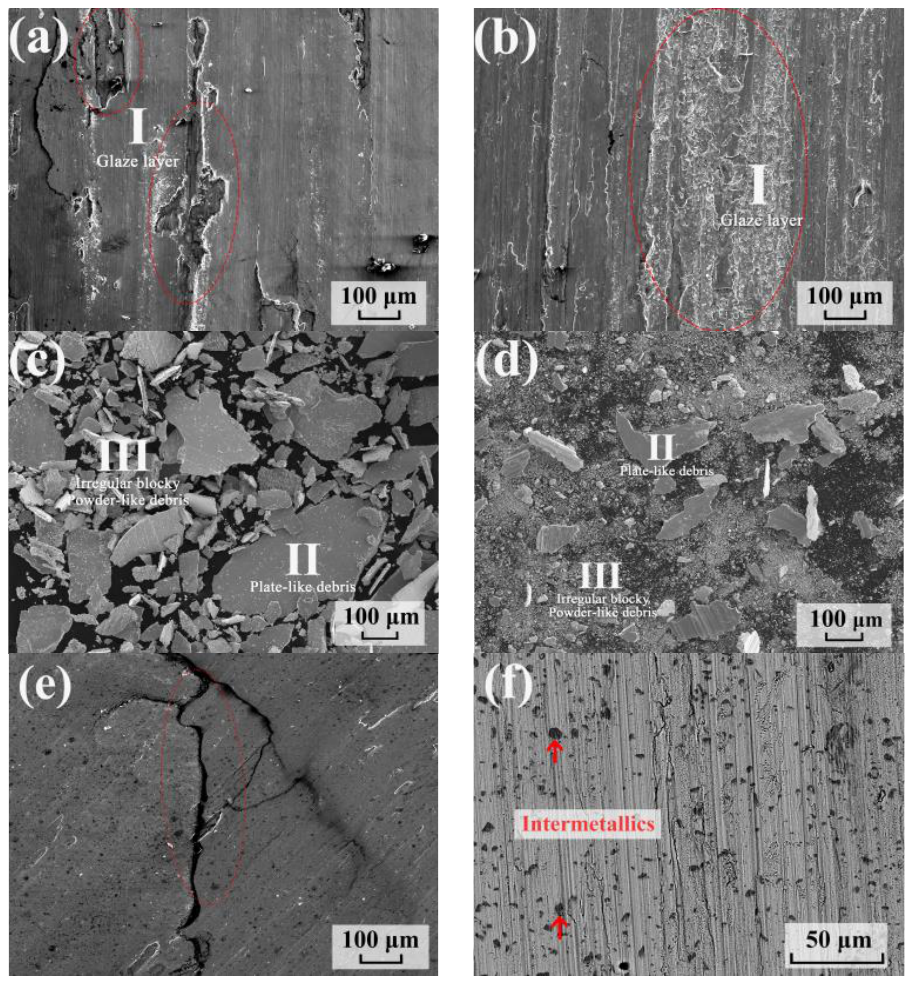
Figure 5. Wear surface and debris of ( a , c ) C17200 alloy and ( b , d ) the Cu 86.5 alloy after pin-on-disc test, ( e ) crack on C17200 surface, and ( f ) intermetallic compound left on the surface. Table 2. Composition of wear surface and debris of C17200 and Cu 86.5 Ni 7.4 Si 3.8 Fe 1.1.